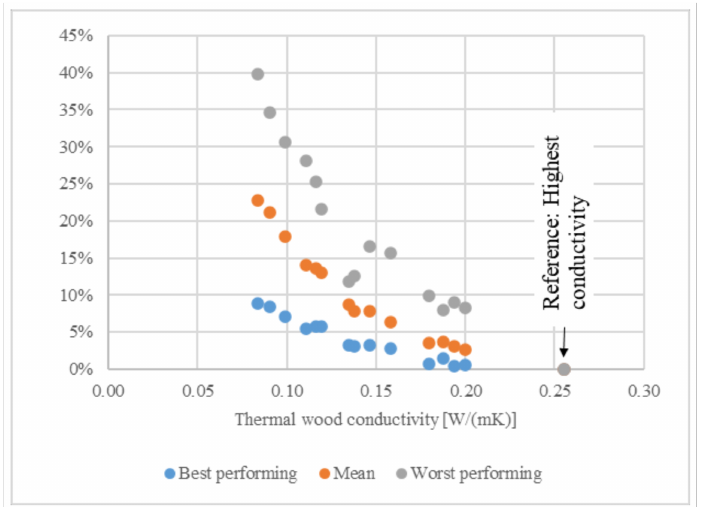
Figure 10. Effect of wood thermal conductivity on start-up lag time: percentage rise of start-up lag time relative to that of the floor with the highest wood covering